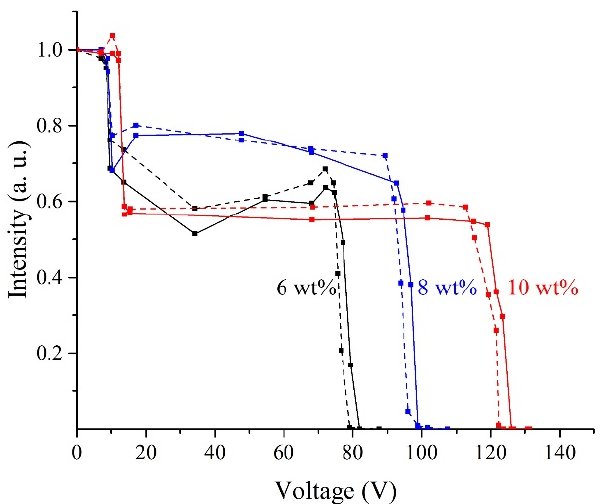
Figure 6. Transmitted light intensity vs. voltage applied to the cell for different concentrations of CD46 (dashed line) and bio-CD46 (solid line). The second drop of intensity shows the critical voltage above which the director orientation is homeotropic.